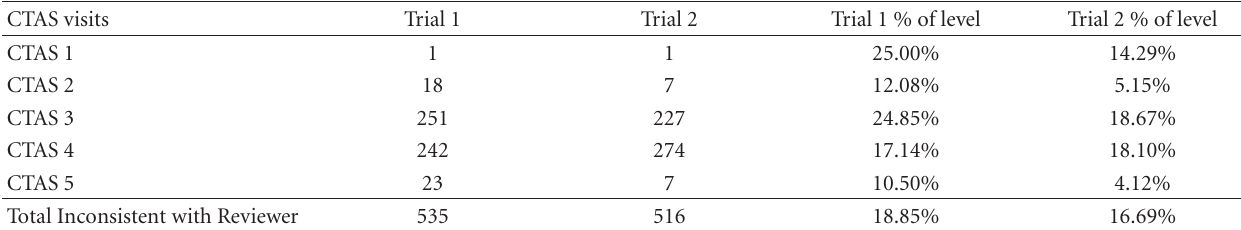
Table 3: Canadian Triage and Acuity Scale (CTAS) level inconsistency compared to nurse reviewer (NR).